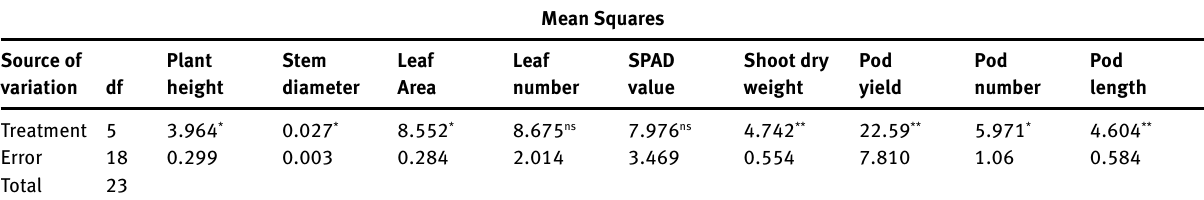
Table 2: Analysis of variance of growth and yield related parameters of green bean plants